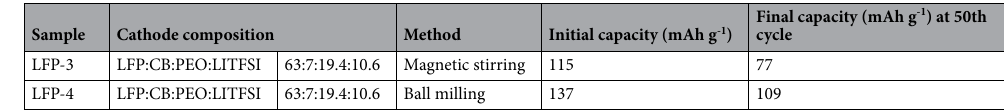
Table 2. Influence of the slurry preparation method (EO:Li = 12:1) on electrochemical performance. The batteries were tested at 1C at 70 °C for 50 cycles using Li/SPNE/LFP configuration.